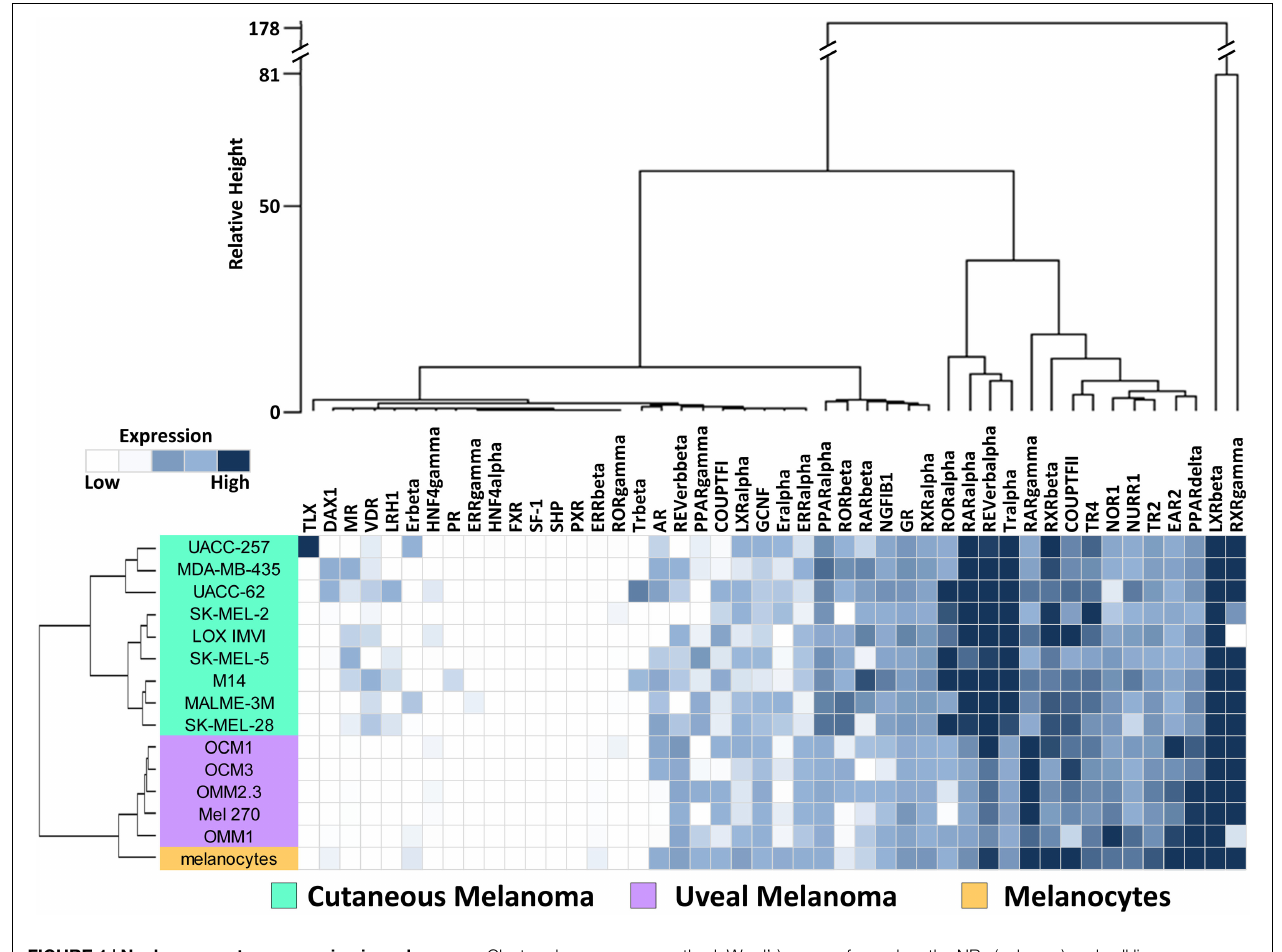
FIGURE 1 | Nuclear receptor expression in melanomas . Clustered heat map representation of mRNA expression levels of the 48 human NRs in a panel of human uveal melanoma ( n = 5) and cutaneous melanoma ( n = 9) cell lines as measured by qRT-PCR. Additionally, a melanocyte was included as a normal comparator. Unsupervised hierarchical clustering (Distance calculations: Manhattan, Aggregation